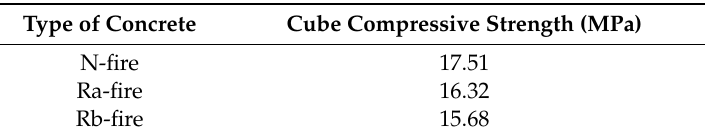
Table 4. Mechanical properties of concrete after fire.